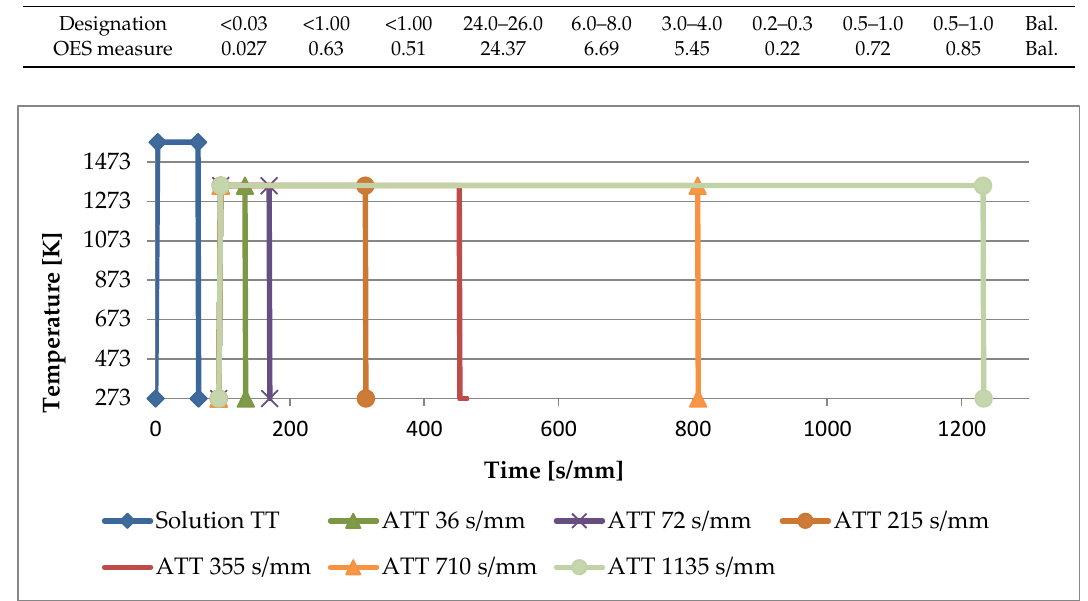
Figure 1. Diagram representing the thermal treatments parameters.